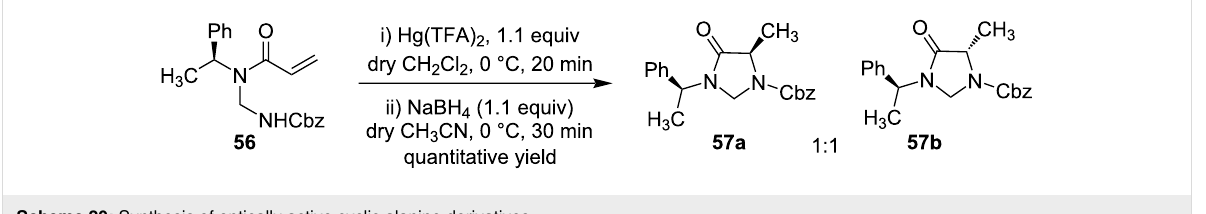
Scheme 20: Synthesis of optically active cyclic alanine